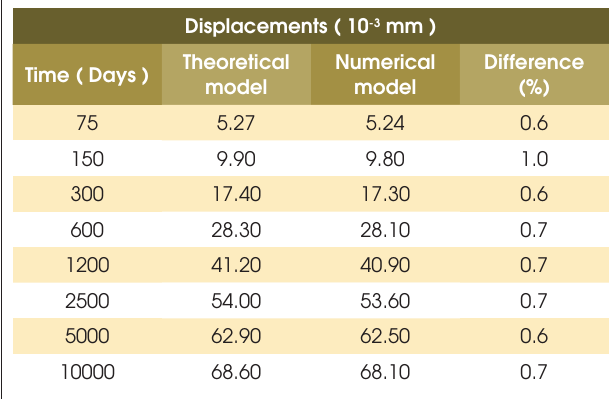
Table 1 – Program validation: displacements by